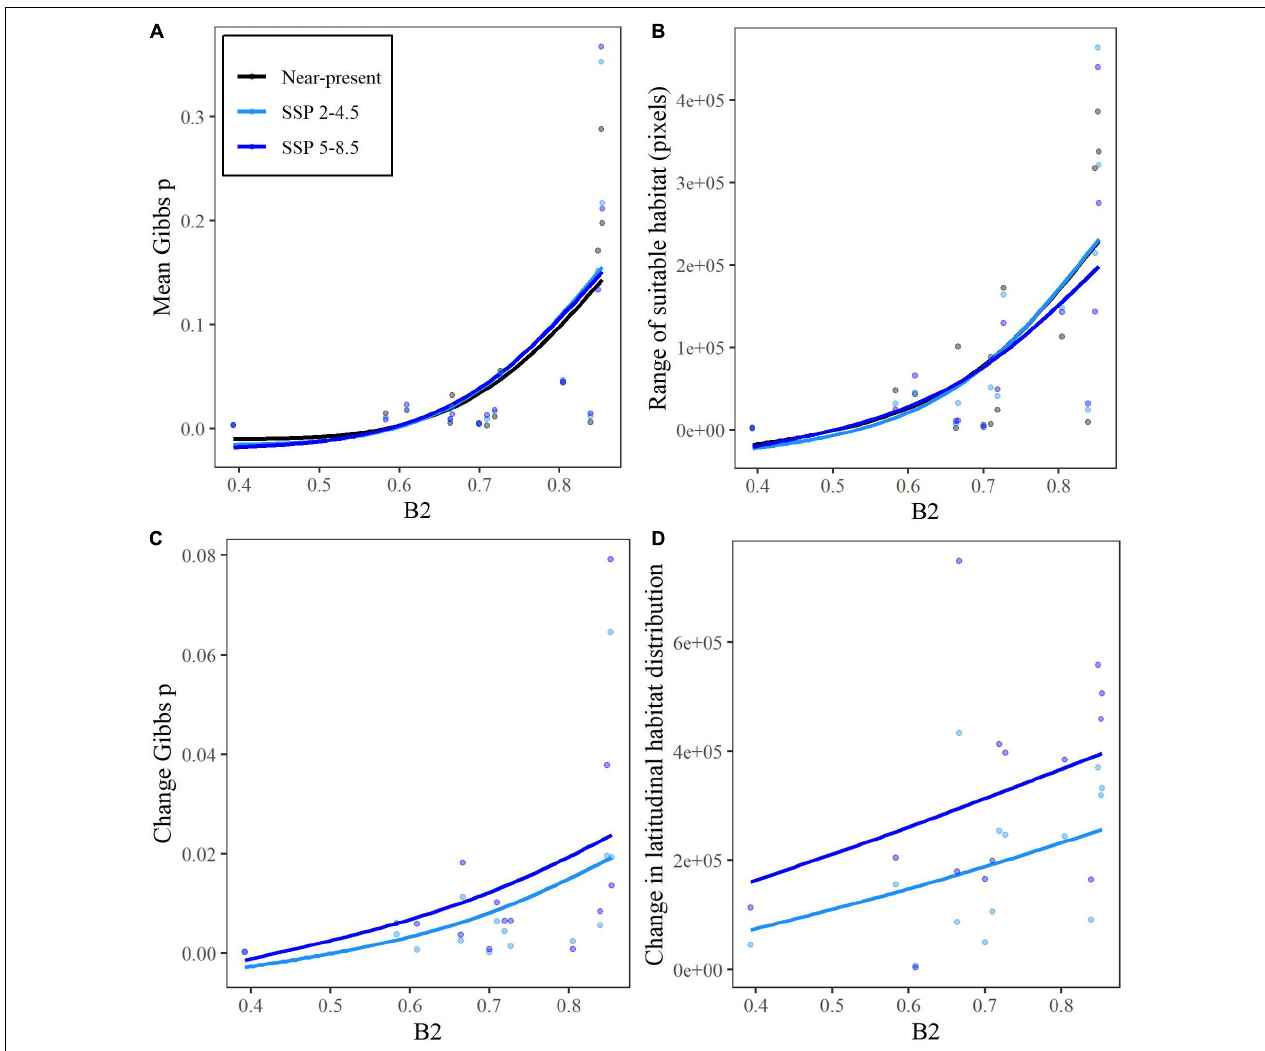
FIGURE 2 | Relationships between Levins’ B2 measure for niche breadth in geographic space and (A) the mean Gibbs p -value (habitat suitability), (B) the spatial range of suitable habitat, (C) change in mean Gibbs p from current to future climate scenarios, and (D) change in latitudinal habitat distribution of 14 Epipactis species. Two climate scenarios were used, SSP 2-4.5 and SSP 5-8.5 to predict the climate for